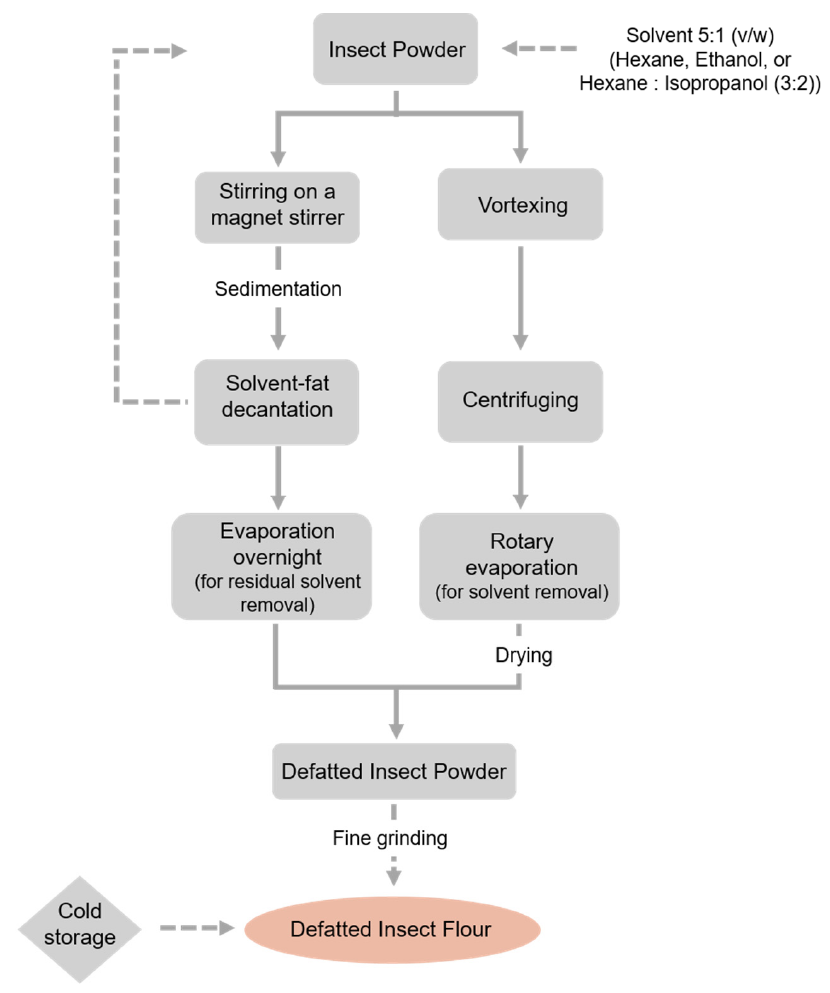
Figure 3. Flow diagram for fat solvent extraction.